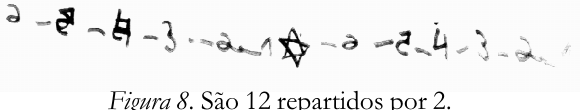
Figura 8. Sªo 12 repartidos por 2.